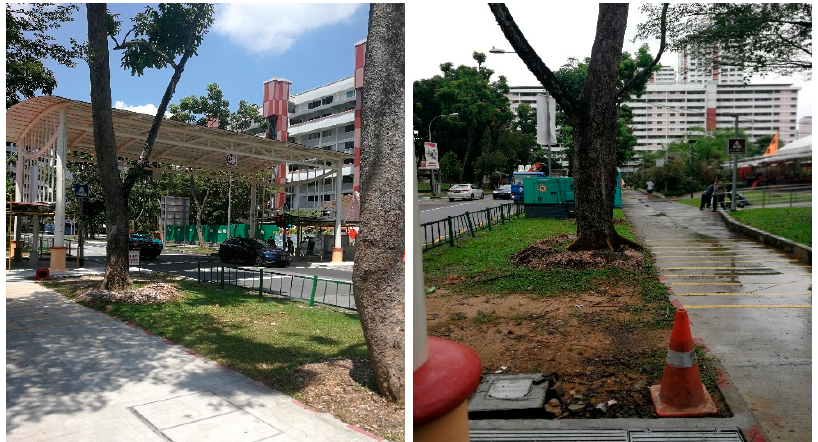
Figure 5 . An added sheltered crossing removes the necessity of walking to the street crossing. Figure 5. An added sheltered crossing removes the necessity of walking to the street